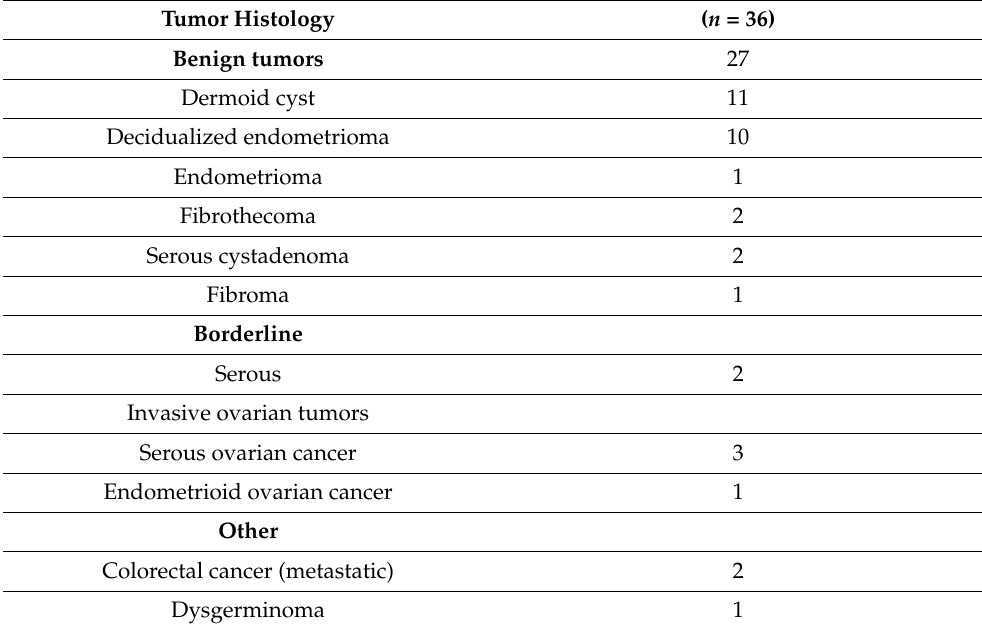
Table 1. Histological diagnosis of adnexal tumors in the studied group of pregnant women. Tumor